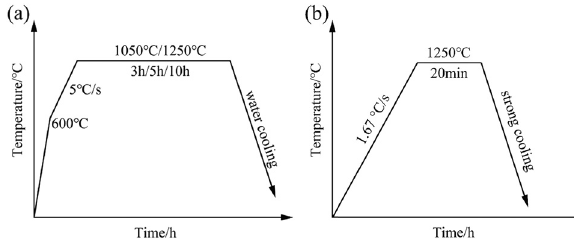
Figure 1: The thermal schedule of ( a ) homogenization treatment and ( b ) in